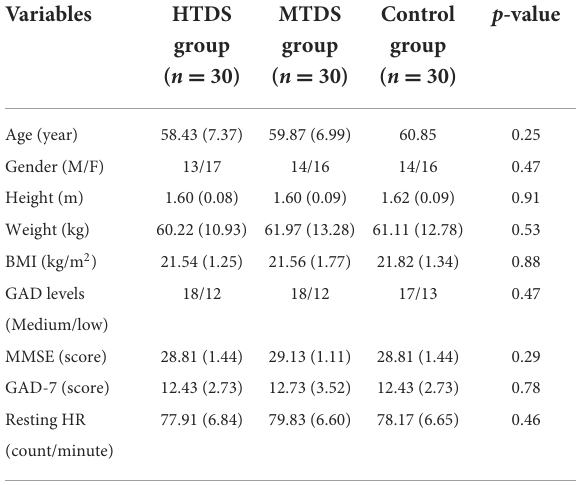
TABLE 1 Baseline demographic characteristics of the participants [mean